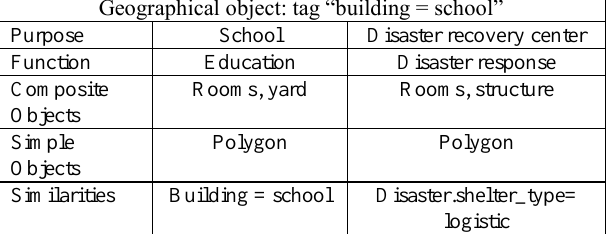
Table 1. Semantic levels for the different contribution of